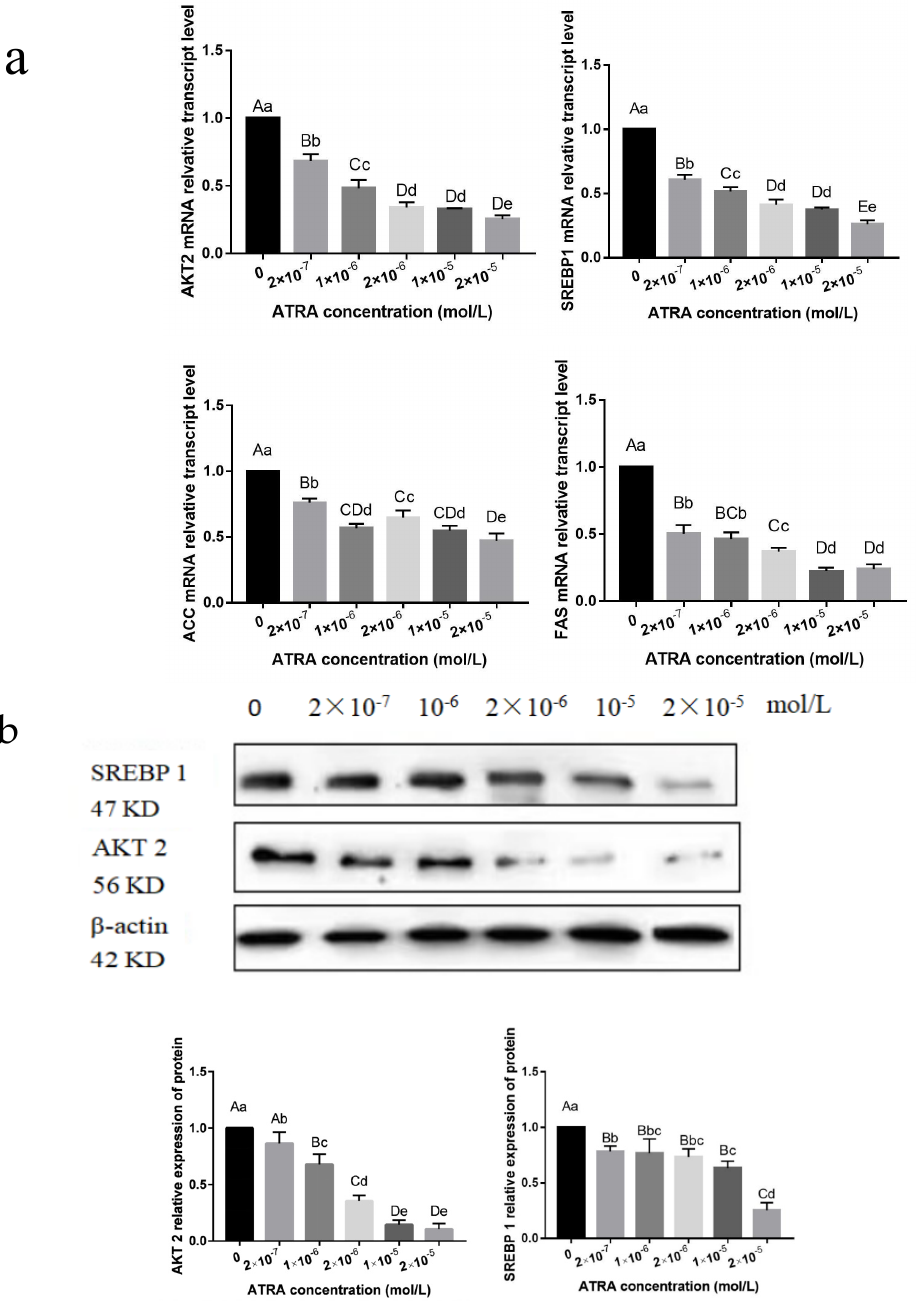
Figure 3. ATRA regulated the differentiation of adipocytes from Yanbian yellow cattle through the mTOR signaling pathway. ( a ) The expression levels of AKT2, SREBP1, ACC, and FAS mRNA were evaluated by qRT-PCR after treatment with different concentrations of ATRA. ( b ) The expression levels of SREBP1 and AKT2 proteins in bovine adipocytes treated with ATRA. Different lowercase letters in the figure indicate significant differences compared with the control group, p < 0.05. Different capital letters indicate highly significant differences compared with the control group, p < 0.01. Full Western Blot Figure S2 and Table S1 are provided in the supplementary file.